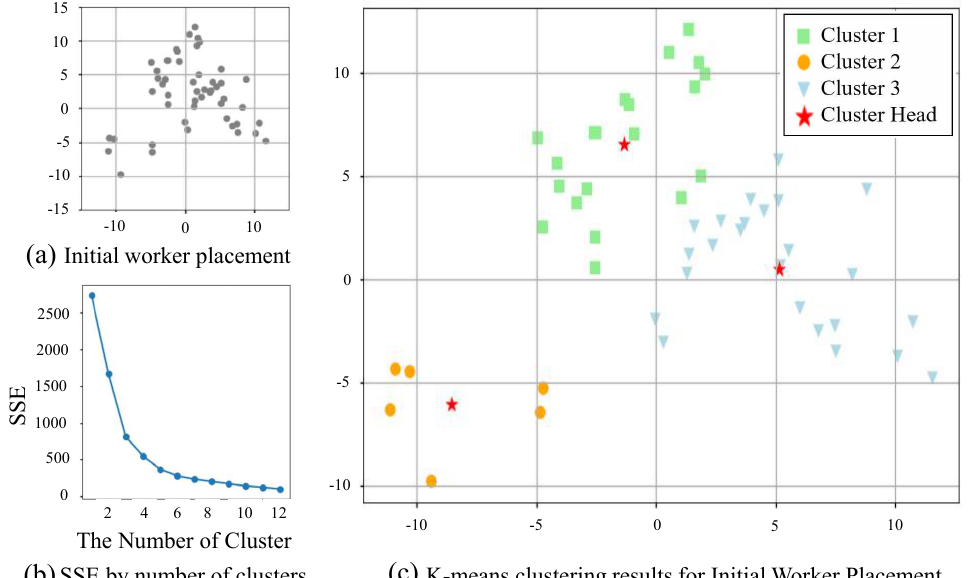
Figure 4. An example of elbow